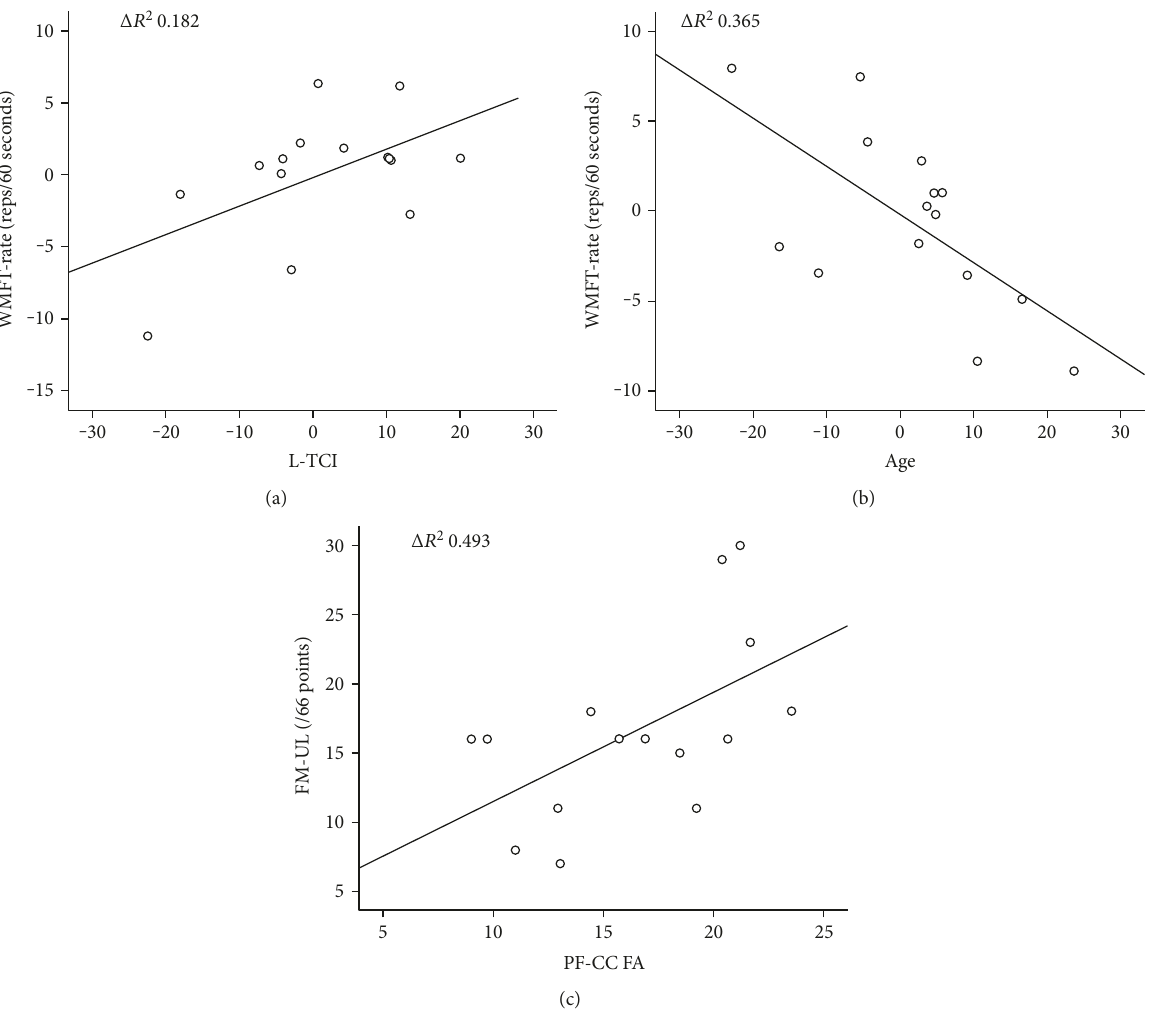
Figure 3: Partial plots for stepwise multiple linear regression model for the cohort of individuals with severe upper limb impairment, n = 15 . (a) Wolf Motor Function Test rate and transcallosal inhibition from ipsilesional M1 to contralesional M1; (b) Wolf Motor Function Test rate and age; and (c) Fugl-Meyer upper limb assessment, prefrontal corpus callosum. WMFT-rate: Wolf Motor Function Test rate; L-TCI: lesioned transcallosal inhibition; FM-UL: Fugl-Meyer upper limb; PF-CC FA: prefrontal corpus callosum fractional